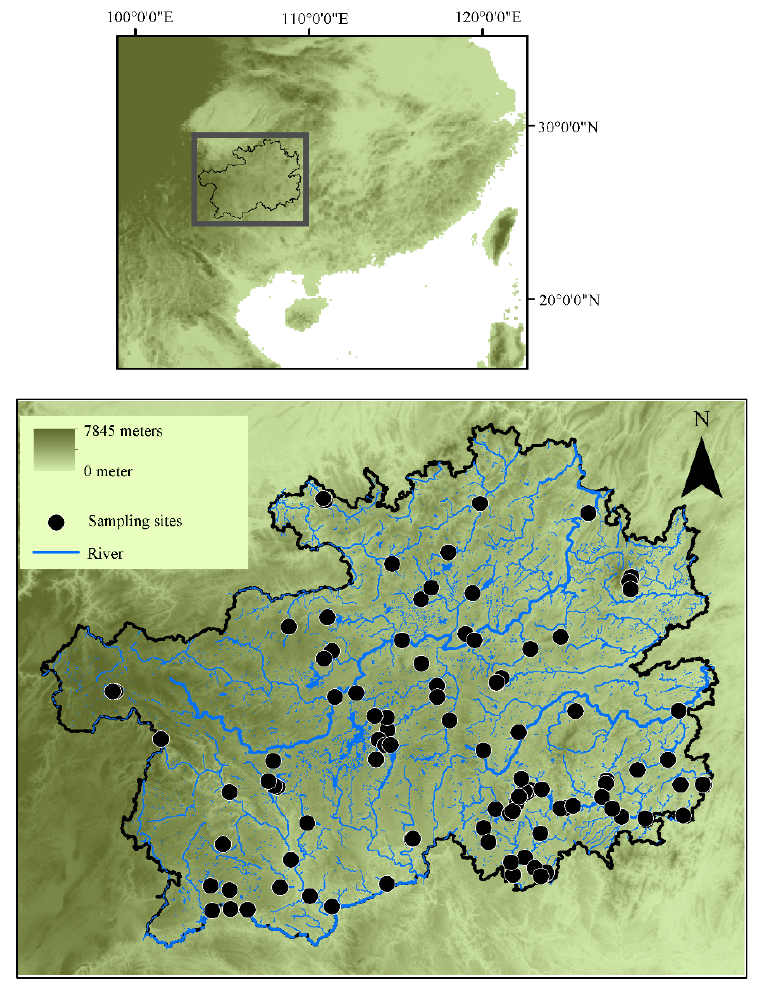
Figure 1. Distribution of the 103 collection sites in Guizhou for 800 samples analyzed for this study. This map was created in the ArcGIS version 10.7. Details of the sampling sites and collected specimens are presented in Table S1.